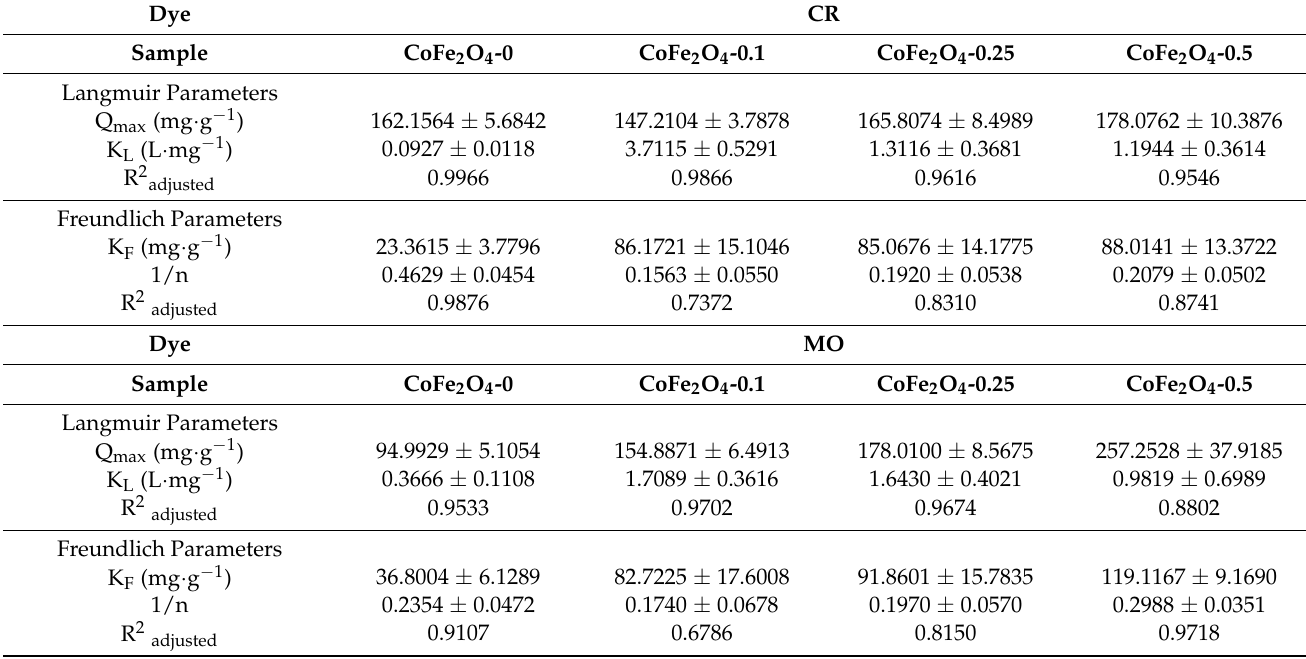
Figure 20. Langmuir and Freundlich fitting curves for MO adsorption onto CoFe 2 O 4 samples. Table 7. Langmuir and Freundlich parameters for dye adsorption onto CoFe 2 O 4 samples from single component